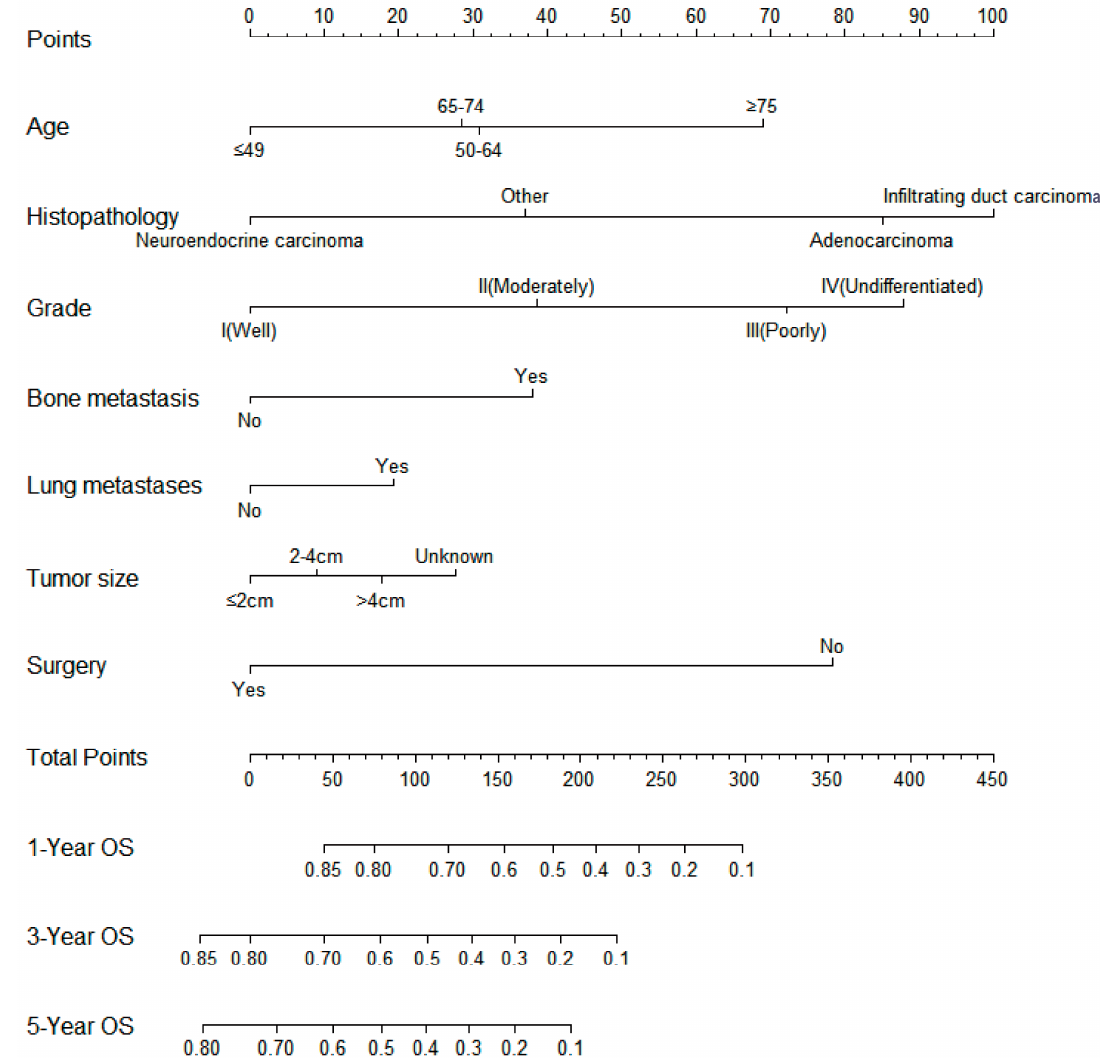
Figure 3. Nomogram model for predicting the overall survival in patients with liver metastases from pancreatic cancer. The scale corresponds to the variable axis according to the patient variables. The overall probability of patient survival at 1, 3, and 5 years can be assessed by drawing a vertical line upward to determine the score for each variable corresponding to the point where the sum of these point scores lies on the total point axis and by drawing a vertical line downward on the survival axis.